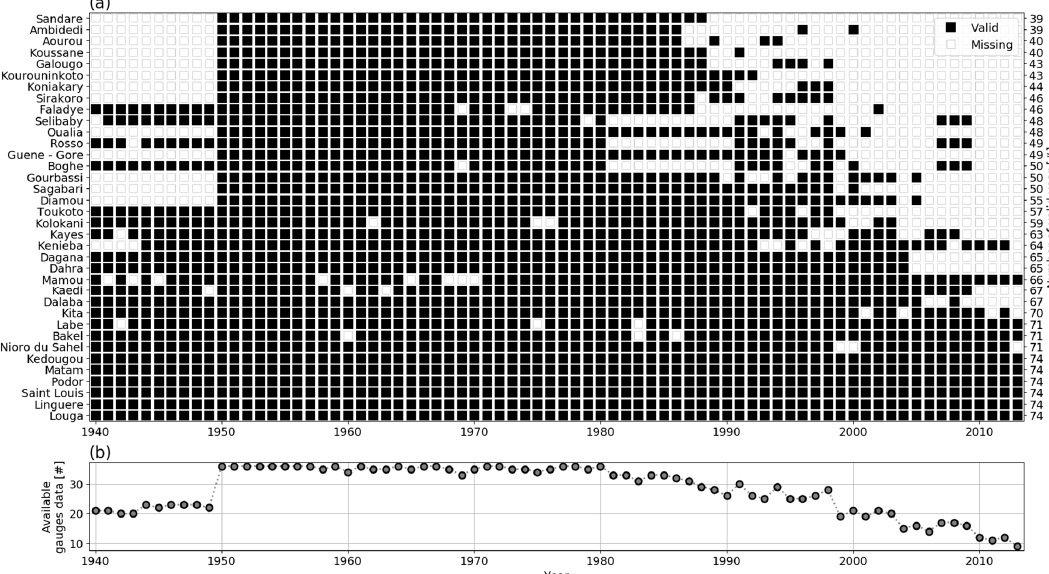
Figure 3. Available annual rainfall data over the period 1940–2013l. ( a ) missing values by station; ( b ) number of available gauges data per year.